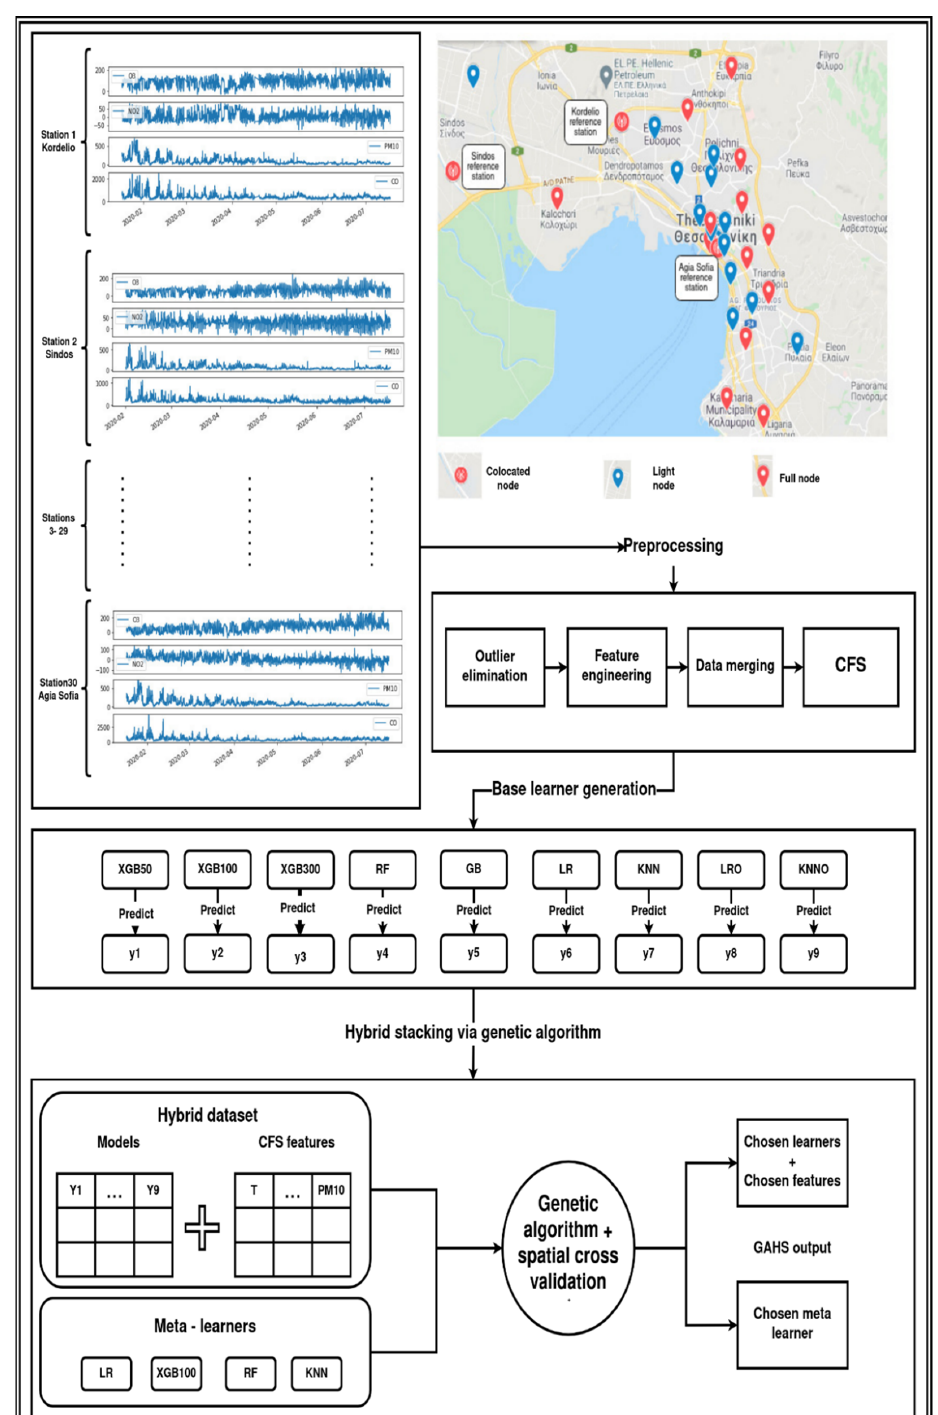
Figure 1. Schematic of the GAHS framework. The AQLCSN installed in the Greater Thessaloniki Area (upper ‐ map) and the computational calibration framework proposed: blue pins correspond to the light nodes (without gas sensors) while red pins to the full nodes (including gas sensors, some nodes fall outside of the current map). The proposed framework includes 3 steps: Preprocessing; base learner generation; Hybrid stacking with the aid of a genetic algorithm. Batch and SOL models are combined with the CFS dataset, and the best combination is computed via a GA. All the abbreviations included here are defined in Sections 2.4 and 2.5.